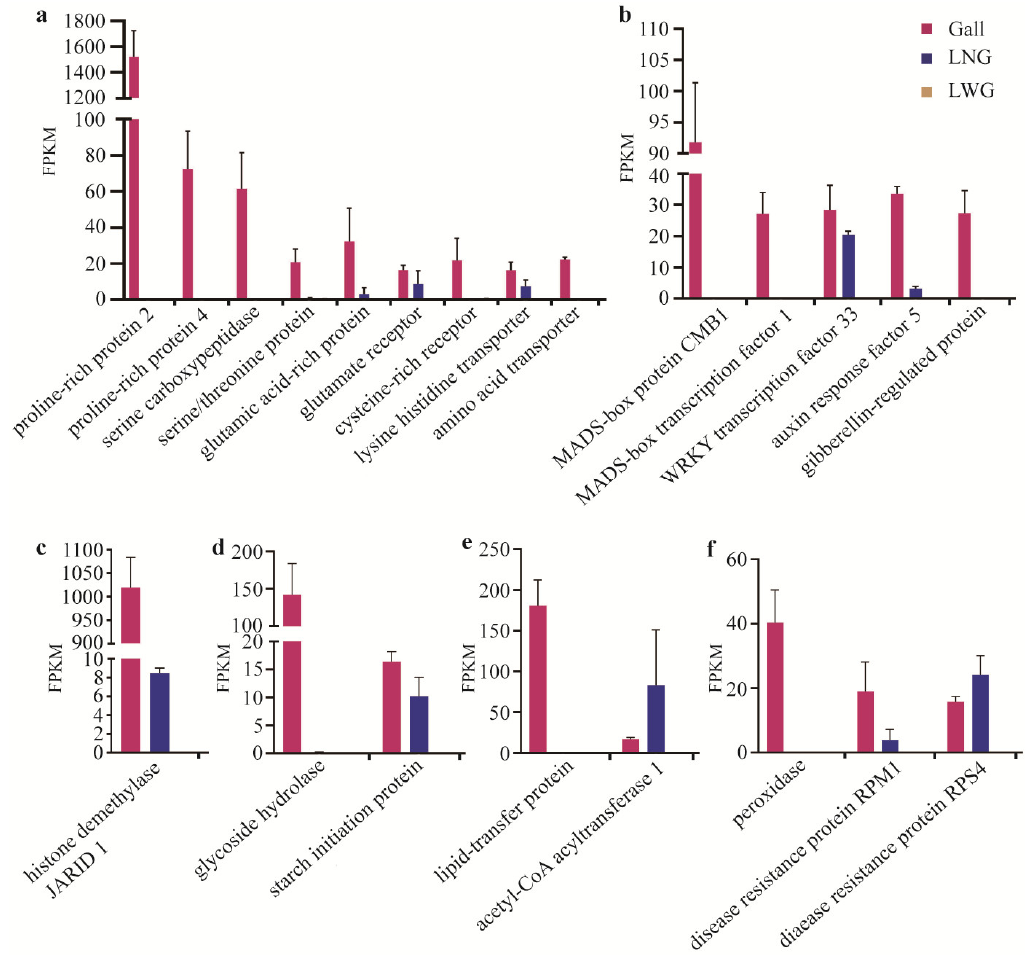
Figure 5. Selective expression genes in the gall and LNG. ( a ) The selective expression unigenes regulated the amino acid pathway. The unigene encoding proline-rich protein 2 showed the highest expression level in the gall. ( b ) The selective expression unigenes regulated the plant development. ( c ) The selective expression unigenes regulated the DNA methylation. ( d ) The selective expression unigenes regulated the sugar pathway. ( e ) The selective expression unigenes regulated the lipid pathway. ( f ) The selective expression unigenes regulated the plant resistance. Most unigenes expressed in the gall only, some unigenes expressed in the gall and LNG, and all unigenes could not be detected in the LWG.